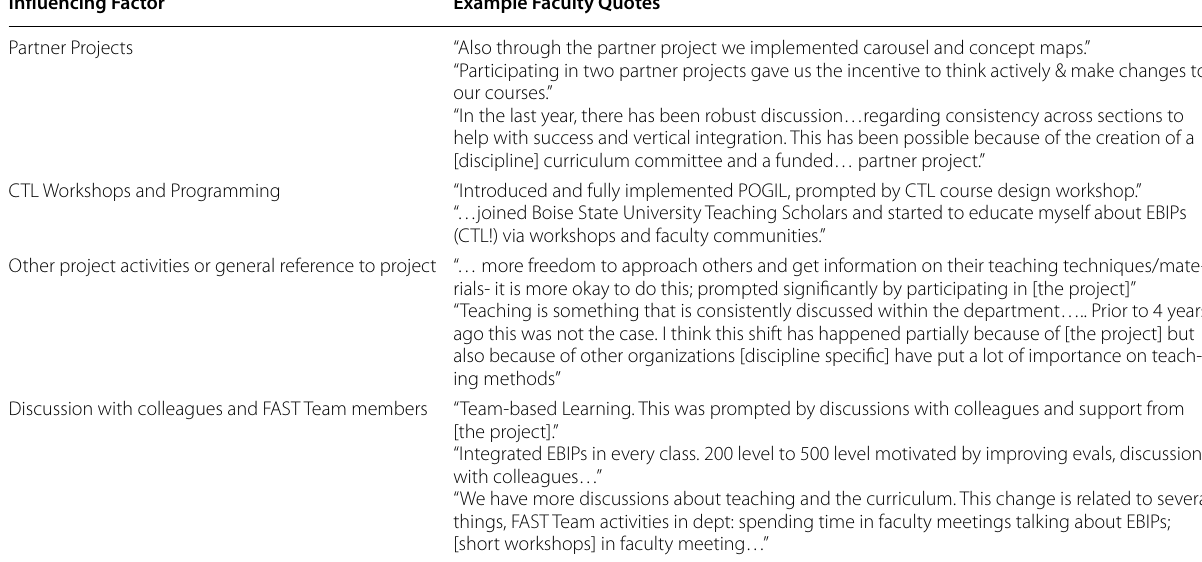
Table 4 Factors cited that prompted change to individual teaching practices or department changes related to teaching Influencing Factor Example Faculty